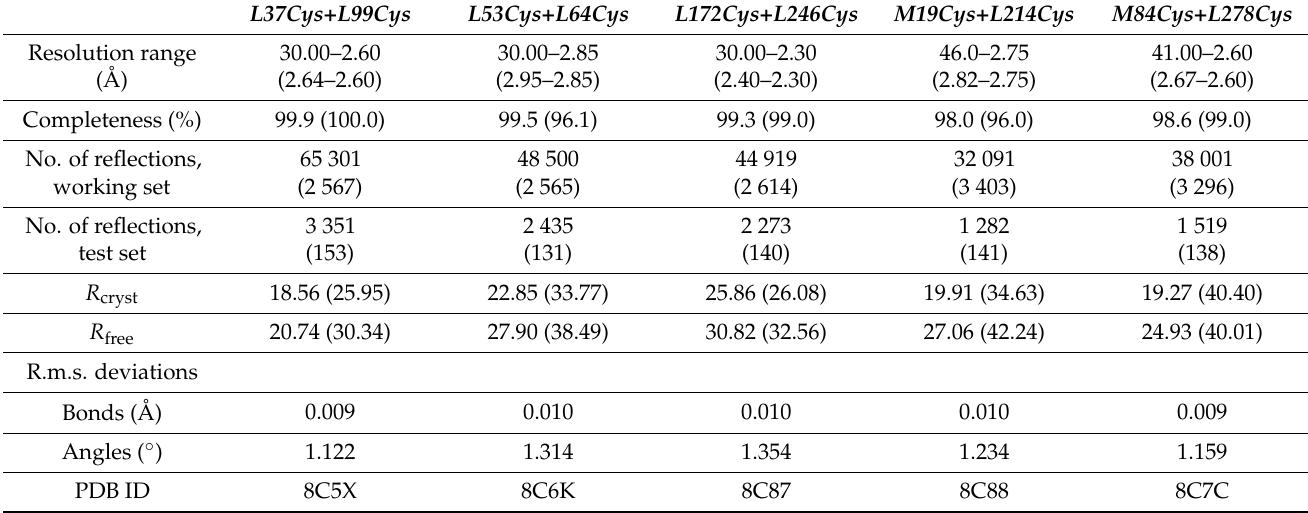
Table 2. Structure solution and